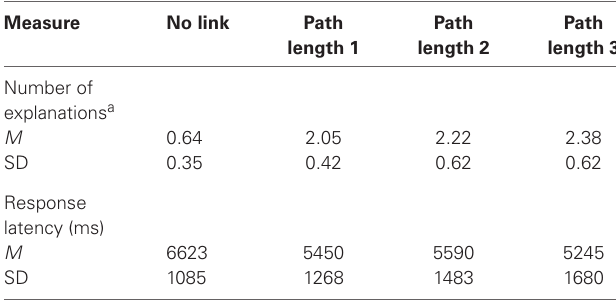
Table 3 | Number of explanations and response latencies for varying path lengths (Experiment